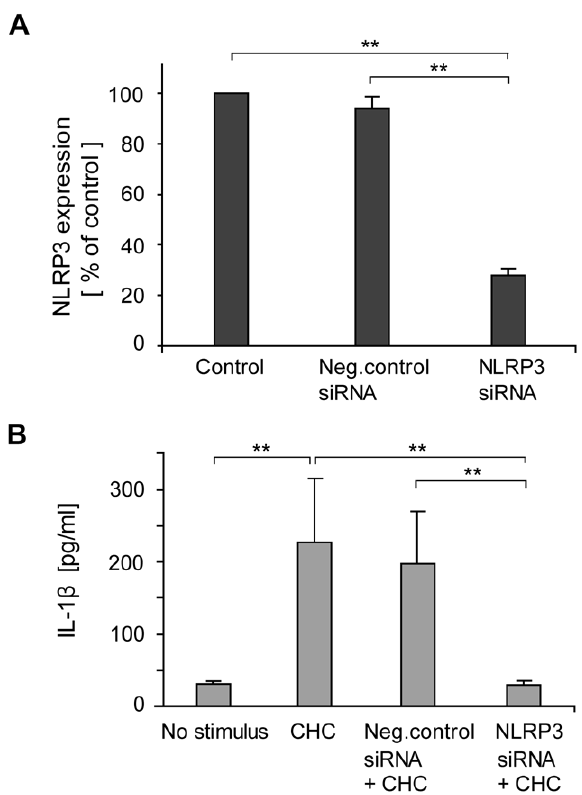
Figure 6. Silencing of NLRP3 attenuates cholesterol crystal (CHC)-induced IL-1 b secretion. (A) NLRP3 mRNA levels were reduced by 72% after treatment of THP-1 macrophages with NLRP3- targeted small interfering RNA (siRNA). (B) CHC-induced IL-1 b secretion was abolished after treatment of cells with NLRP3 siRNA, whereas treatment of cells with negative control siRNA had no effect. The data are means 6 s.e.m. from 5 (A) and 3 (B) experiments. **=p , 0.01.